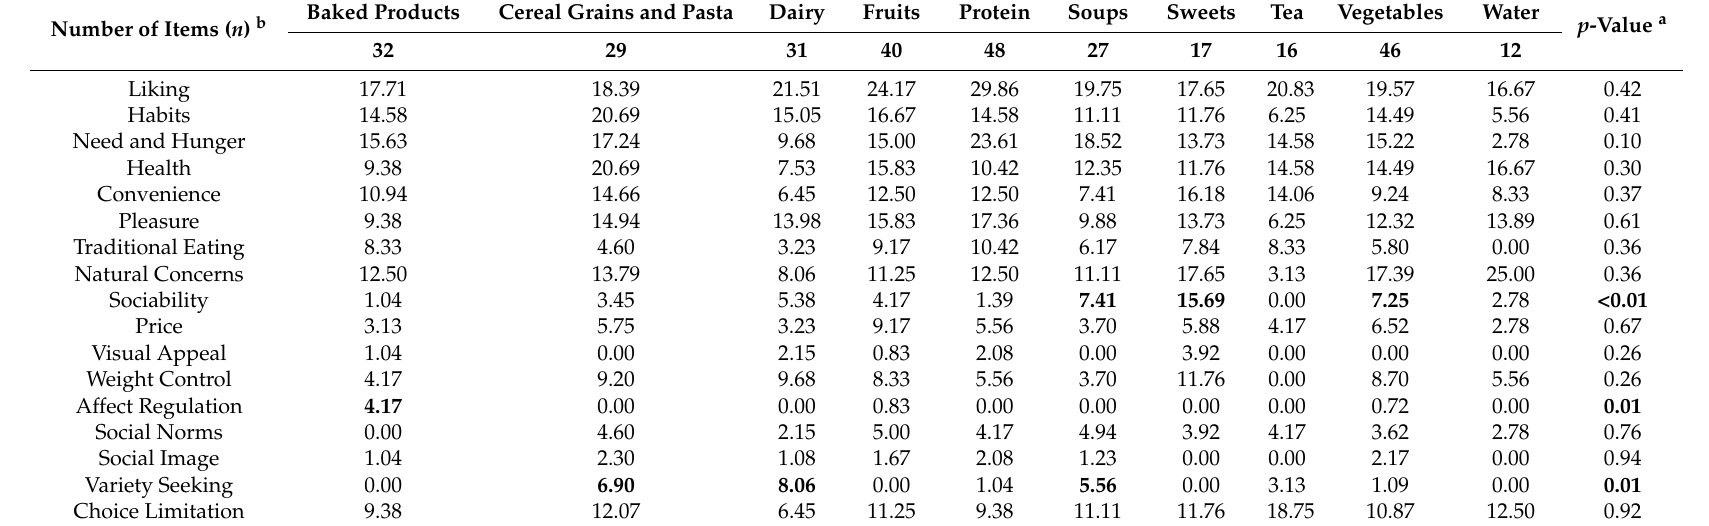
Table 3. The percentages of the motivations associated with 10 different food groups reported by 141 Turkish